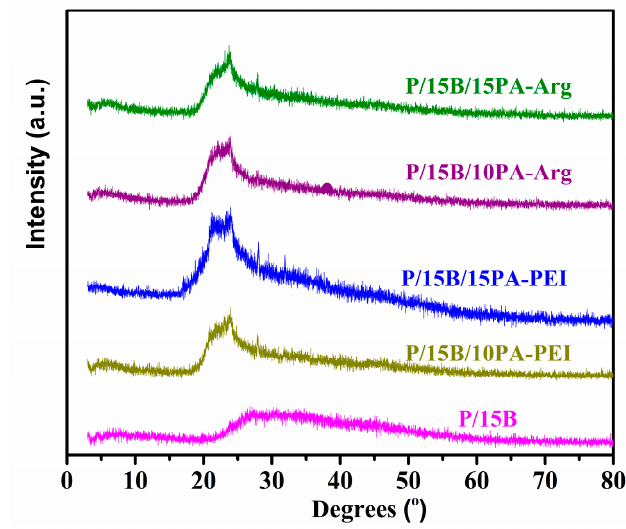
Figure 4. X-ray diffraction patterns of P/15B-based composites.